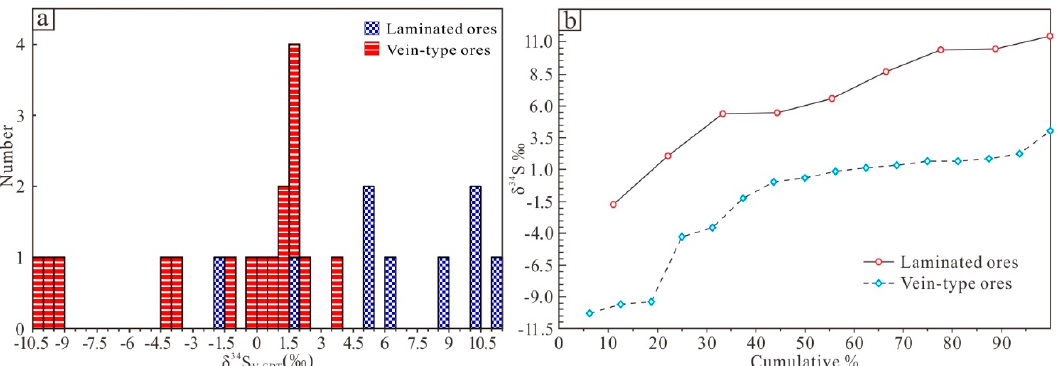
Figure 9. ( a ) Histogram and ( b ) CDF (cumulative distribution funtion) diagram of in situ sulfur isotope compositions of sulfide minerals from laminated and vein-type ores at the Hongnipo